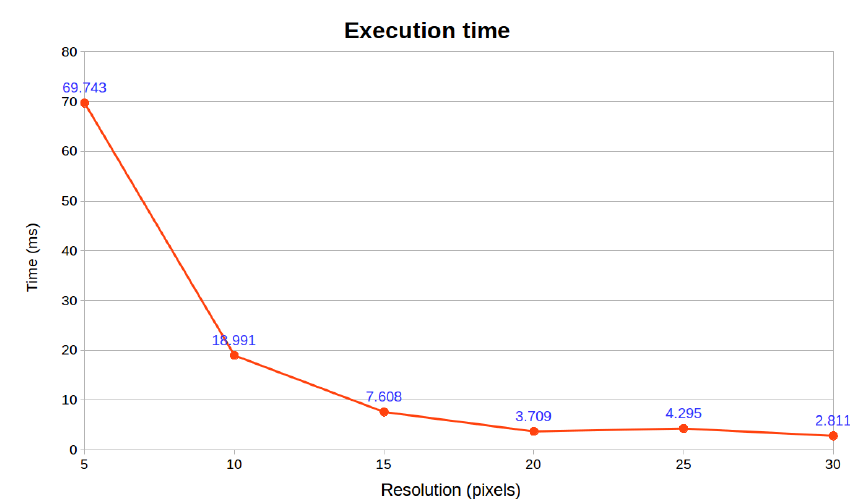
Figure A9. Chart of radio coverage execution times for different resolutions of cell from 5 to 30 pixels. This statistics was recorded for the performance on a PC equipped Core